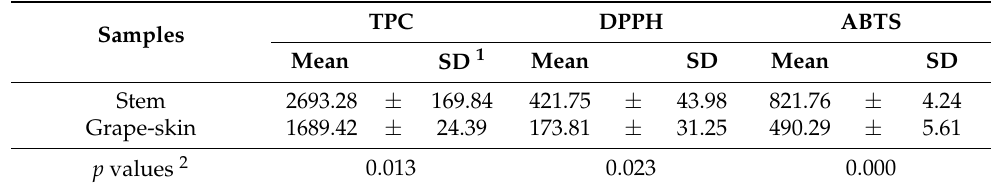
Table 1. Total phenolic content (TPC) expressed in mg gallic acid equivalent (GAE)/100 g extract and antioxidant activity (DPPH and ABTS) expressed in mg Trolox/100 g extract of the stem and grape-skin.